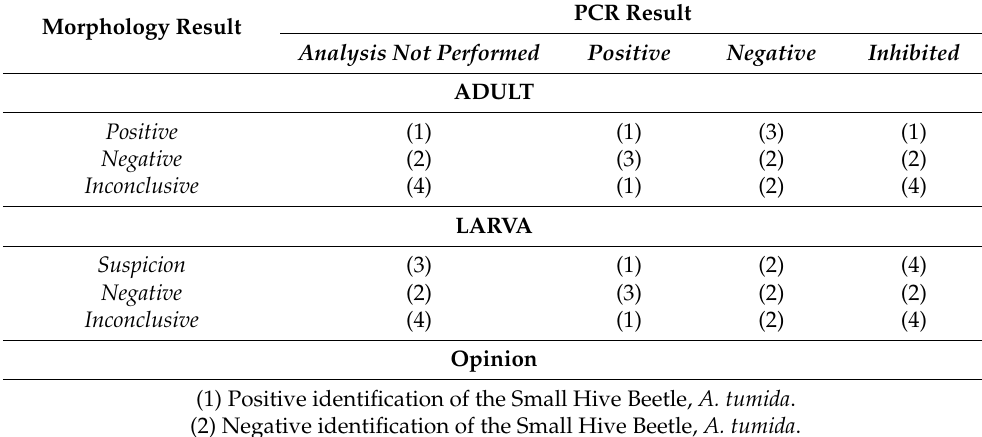
Table 3. Decision rules for expressing opinions, taking into consideration morphology and PCR results. Morphology